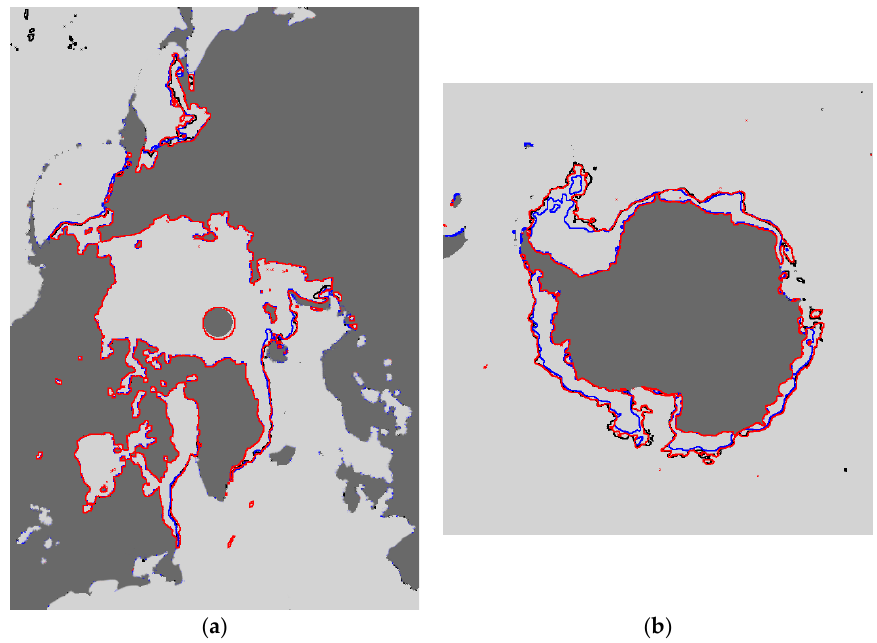
Figure 11. Ice-edge map on the 10 January 2019 for the ( a ) Arctic and ( b ) Antarctic, CSCAT black line, SSMI blue line, ASCAT red line.